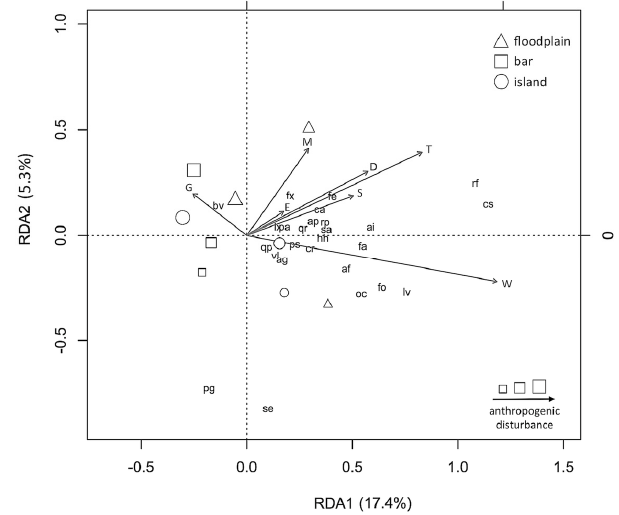
Figure 9. RDA ordination biplot of the observations on 234 plots. Arrows represent the biplot scores